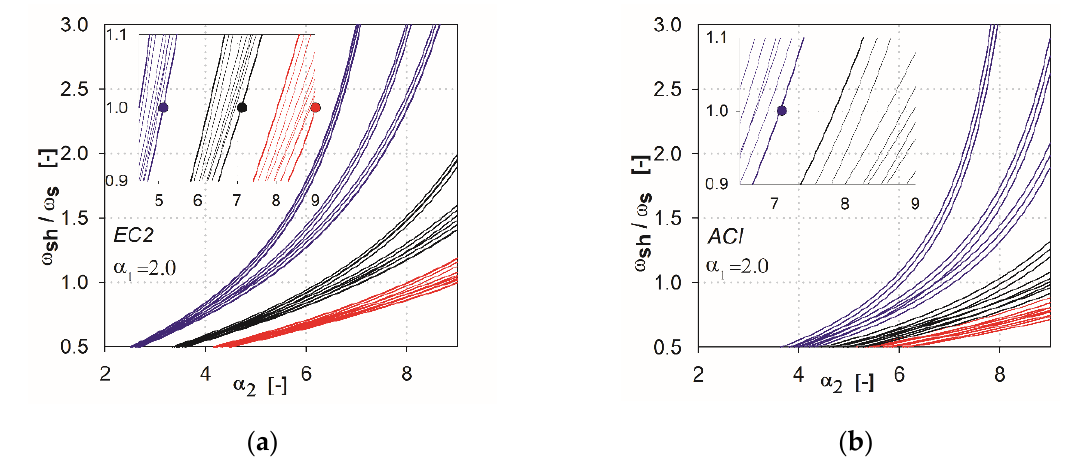
Figure 10. Graphs obtained for the parameter 𝛼 1 = 2.0 : ( a ) for the EC2 standard; ( b ) for the ACI code.